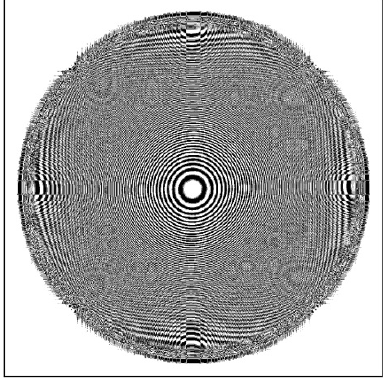
Figure A2. Generated aberration functions using the Zernike coefficients sets. The first nine indi- vidual functions.